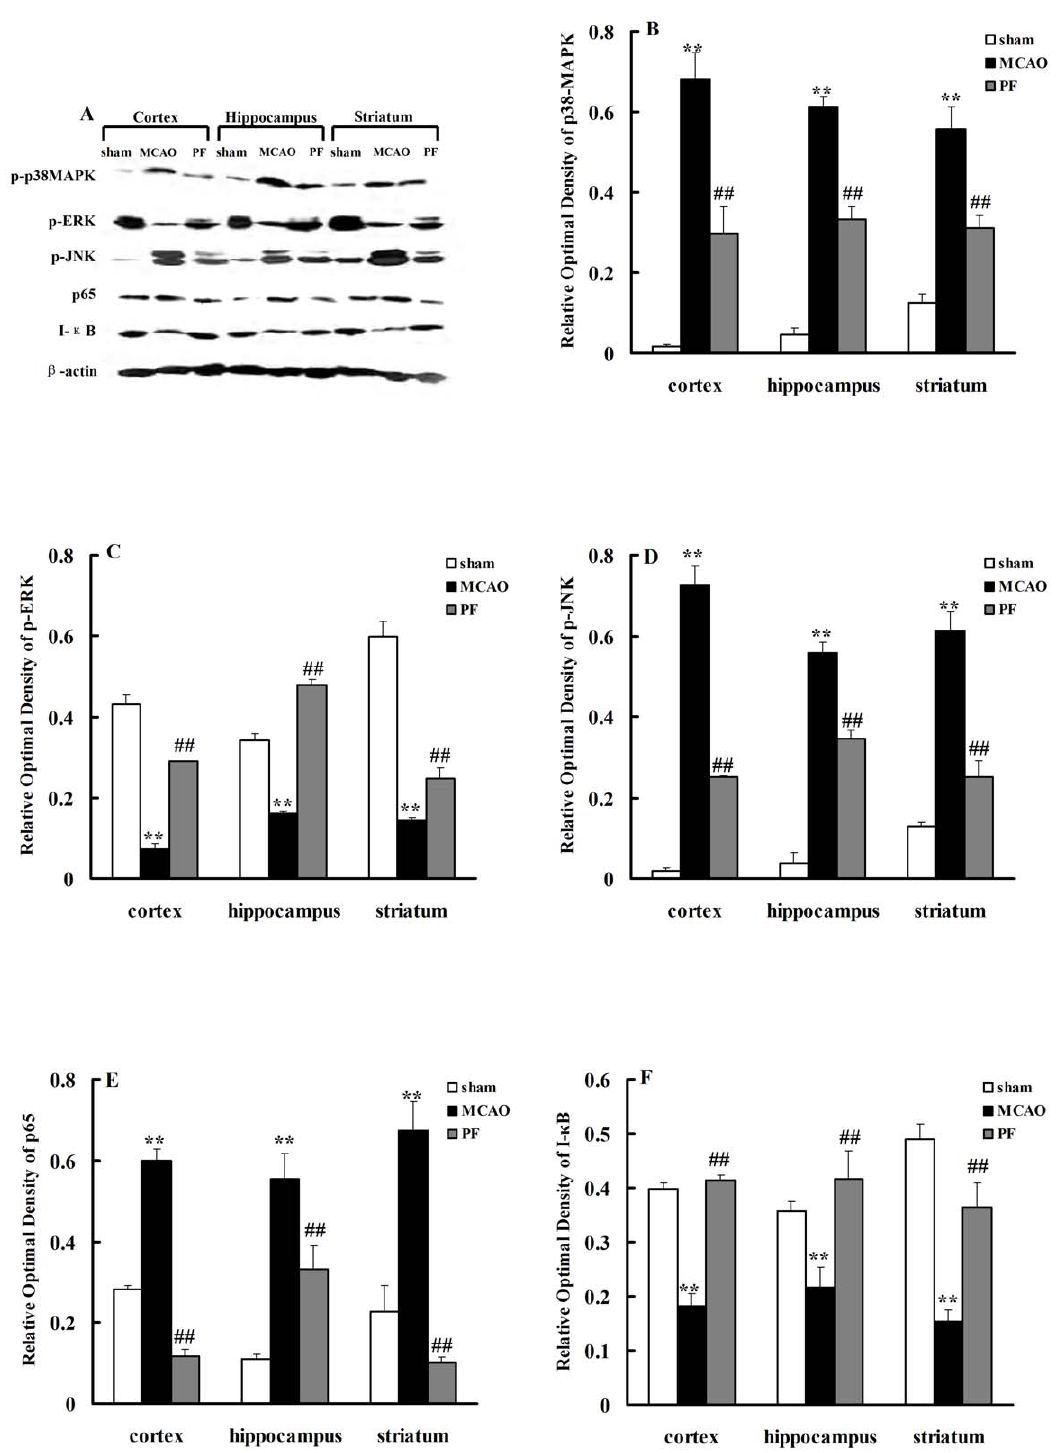
Figure 6. Effects of PF on MAPK and NF- k B signaling effectors expression. p-P38 MAPK, p-ERK, p-JNK, p65 and I k B protein expressions in the cortex, hippocampus and striatum of rats were indicated in (A). The relative optical densities were indicated in (B–F). Sham, rats received surgery without vessel occlusion; MCAO, rats treated with saline for 14 days after transient MCAO; PF, PF (5 mg. kg 2 1 ) was administered for 14 days after MCAO. n=4. All data were expressed as mean 6 SD. ** P , 0.01 vs sham; ## P , 0.01 vs MCAO.